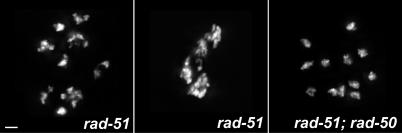
Abnormal Chromosome Morphology Associated with rad-51 Mutants Is Suppressed in rad-51; rad-50 Double MutantsEach panel shows the full karyotype in a single diakinesis-stage oocyte. Diakinesis oocytes in the rad-51 mutant typically have abnormal-appearing, poorly condensed chromosomes (left) and/or aggregated masses of chromosomes (middle), whereas diakinesis oocytes in the rad-51; rad-50 double mutant exhibit well-formed, non-aggregated univalent chromosomes (right). Scale bar = 2 μm.